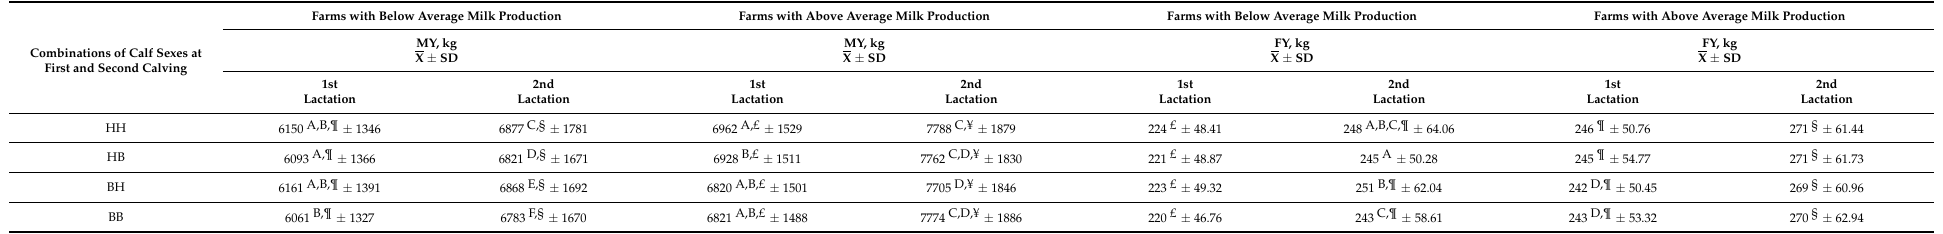
Table 6. Effect of the combination of sex of calves during the first and second calving on milk yield (X ± SD) and fat yield (X ± SD) in the 1st and 2nd standard lactation depending on the level of production on